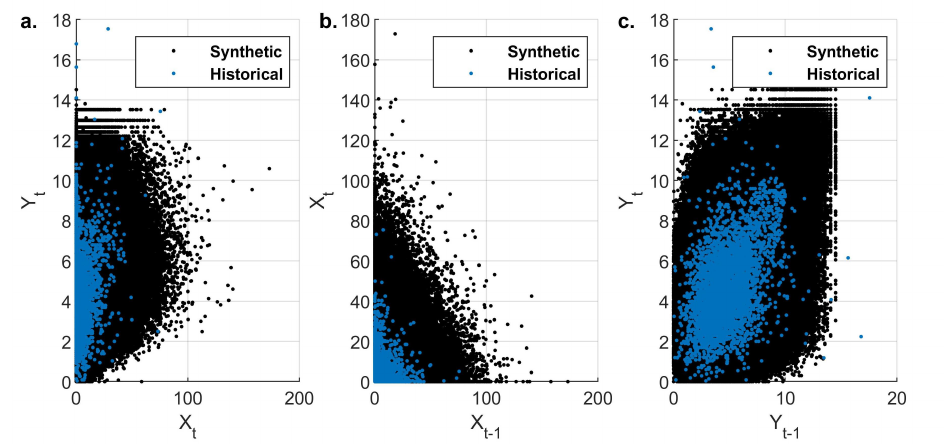
Figure 7. Scatter plot presenting the dependence structure of historical and synthetic data.